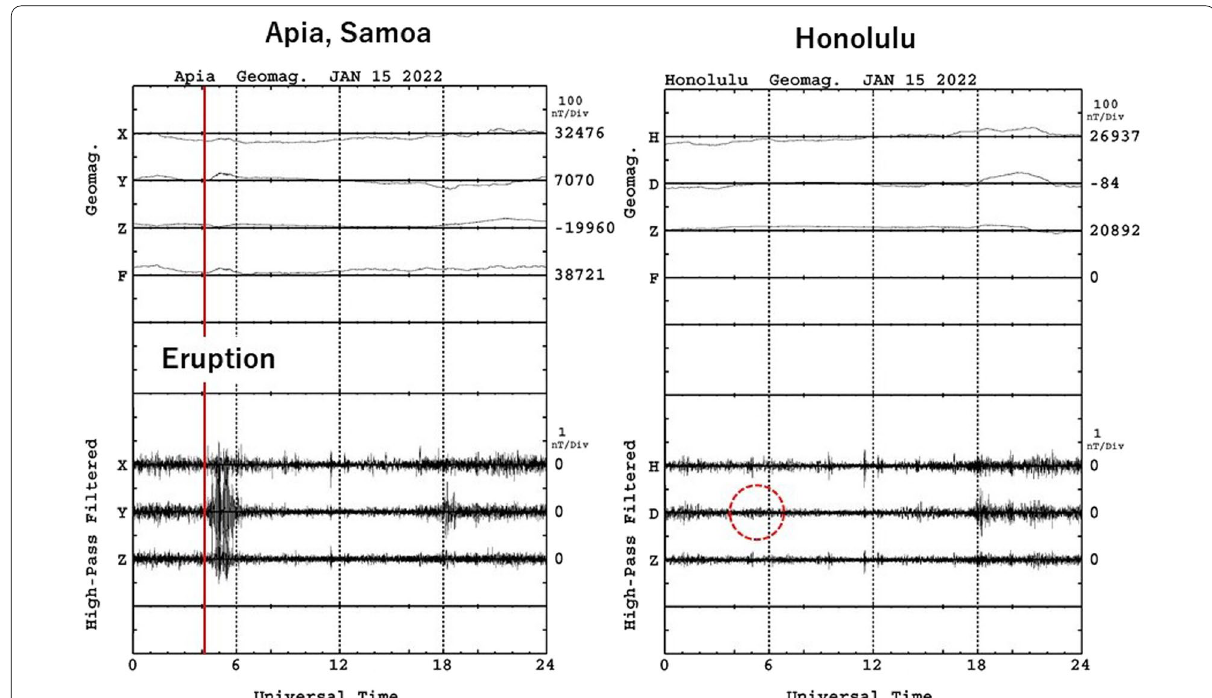
Fig. 1 Geomagnetic field variation at Apia and Honolulu. The upper 4 traces are the variations after baseline subtraction and the lower 3 traces shows the high-pass filtered data. Note that the D-component of Honolulu data are converted to nT unit in approximately eastward